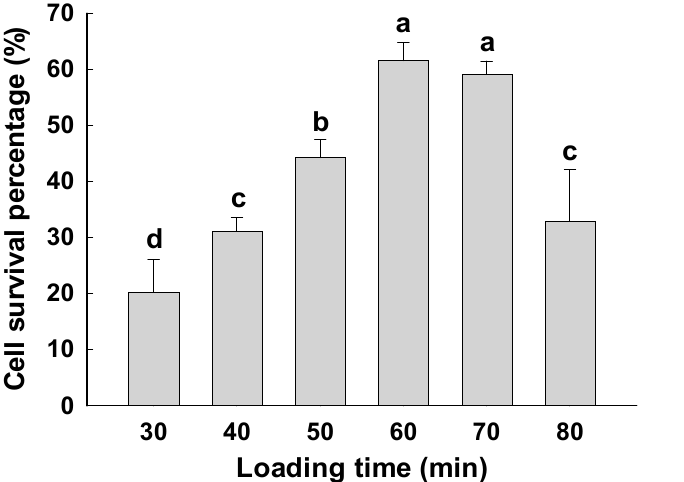
Figure 3. Effects of loading time on cell survival percentage of F. mandshurica EC after cryopreservation by vitrification. Note: Different letters are significantly different from each other at p < 0.05, using Duncan’s Multiple Range Test.